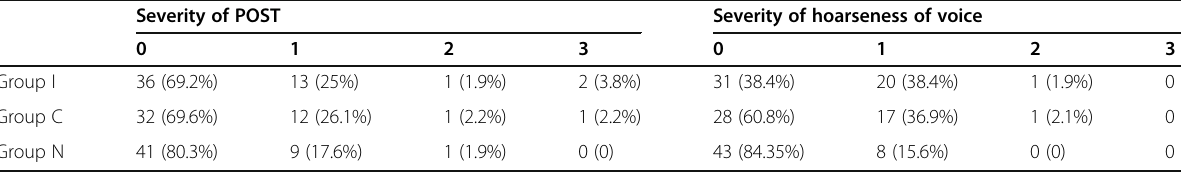
Table 3 Grading and severity of POST and hoarseness of voice Severity of POST Severity of hoarseness of